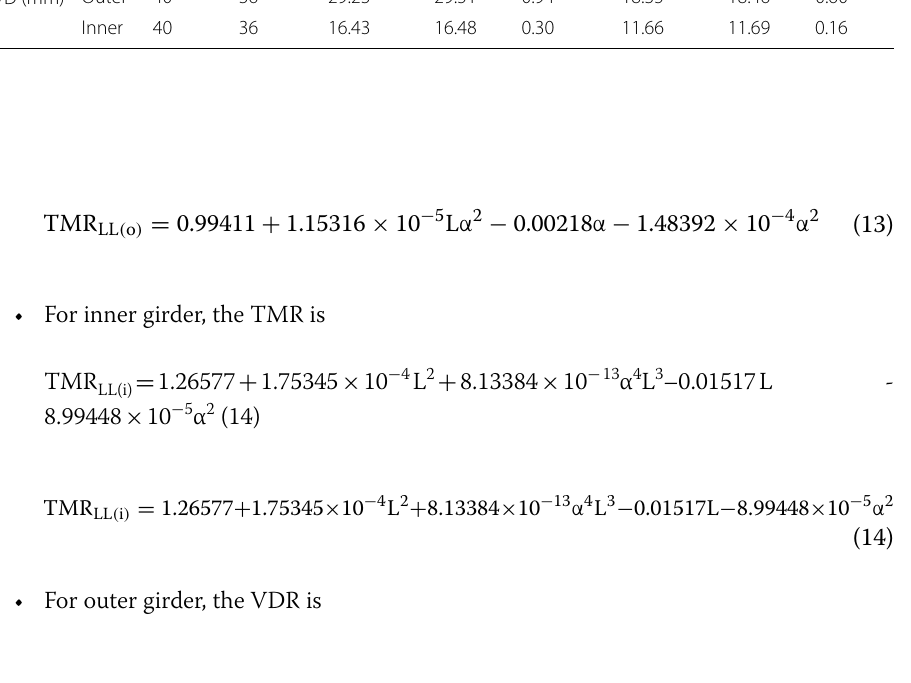
Curve For dead load For live load (m) angle Using (degree) proposed equation